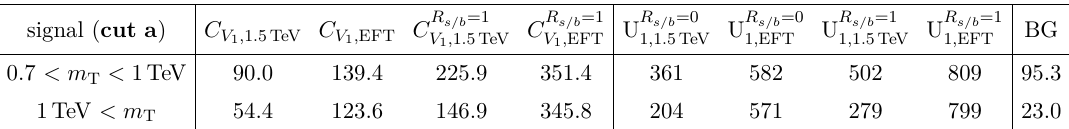
Table 3 . Expected numbers of signal events after cut a (the τ ± ν search) for R L dt = 35 . 9 fb − 1 √ s = 13 TeV in the single C V and scenario (from second to fifth columns) and the U(2) -U 1 scenario 1 ( C S = − 2 β R C V ) (from sixth to ninth columns). In all cases, C V = 1 is fixed, while the LQ mass 1 1 1 is M LQ = 1 . 5 TeV or 20 TeV (the EFT limit). The s -quark contribution, parameterized by R s/b , is also studied. The last column is the expected number of SM background (see table 1). Detailed cut flows are shown in tables 11 and 12.